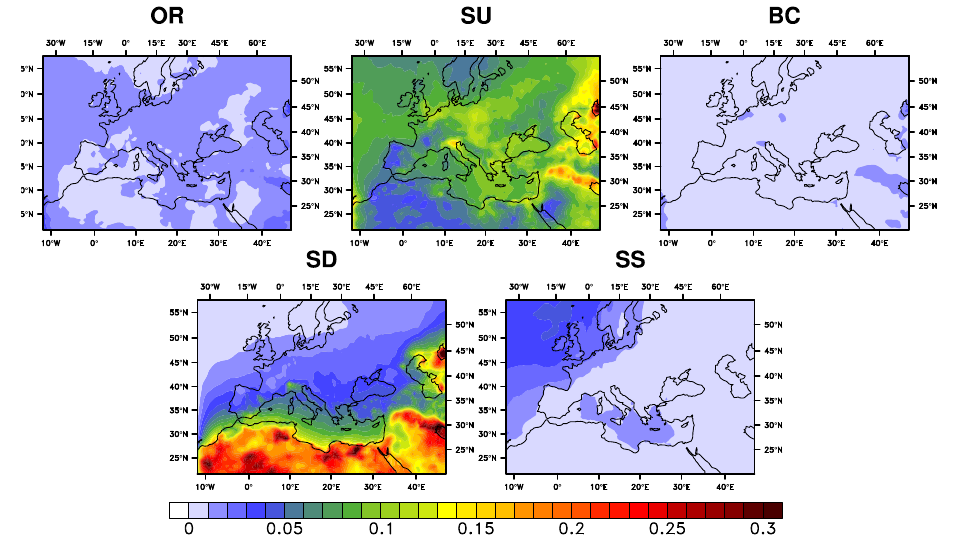
Fig. 15. Average aerosol optical depth of the reconstruction product over the period 2003–2009 for each aerosol type (OR=organic carbon, SU=sulfates, BC=black carbon, SD=soil dust, SS=sea salt). 1979 and 2002. AOD INCA is the AOD from the LMDz-OR- INCA model given with eleven-year moving averages. As a result, contrary to the 2003-2009 period, there is no year to year variability in the reconstruction between 1979 and 2003, 1220 but only a decreasing trend for sulfate aerosols.